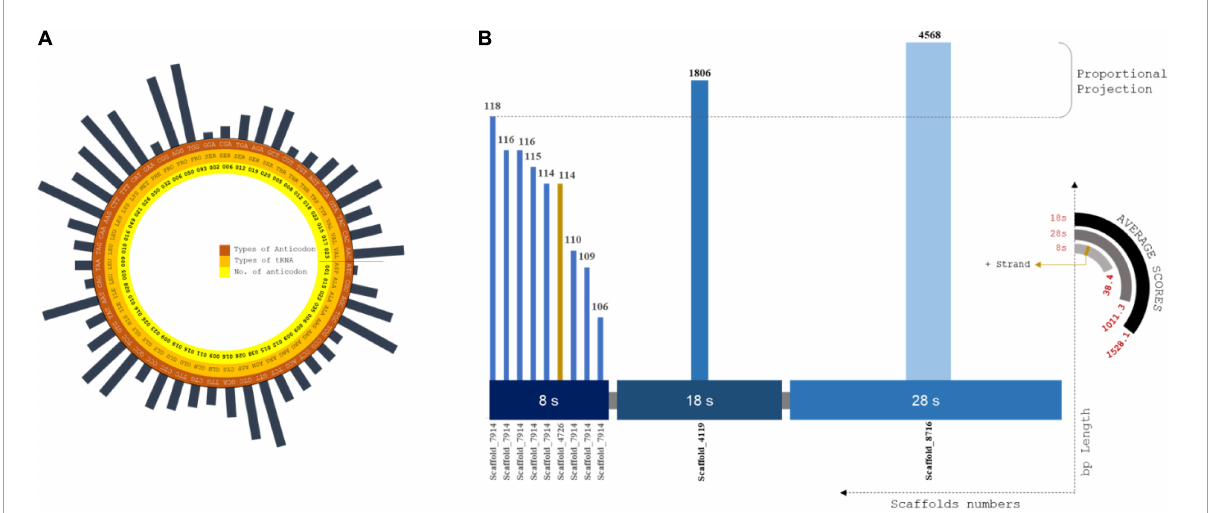
FIGURE3 (A) Circular plot of tRNA composition from scaffolds assembled: Layers of tRNA distributed as codons, amino acids and no. of codons screened. Largest codon usage by Proline (TGG) which is of 93 nos. and the lowest codon usage is Aspartame, i.e., 1 of ATC codons. (B) rRNA plot by distributed size of ribosomal RNA subunits against the scaffold utilized for prediction using RNAmmer. X coordinates are subunit classification and y coordinate classifies scaffold count and length of each scaffolds. The pseudo-semi-circular projections depicts the score value of each prediction and strand profile of predicted rRNA profiles.